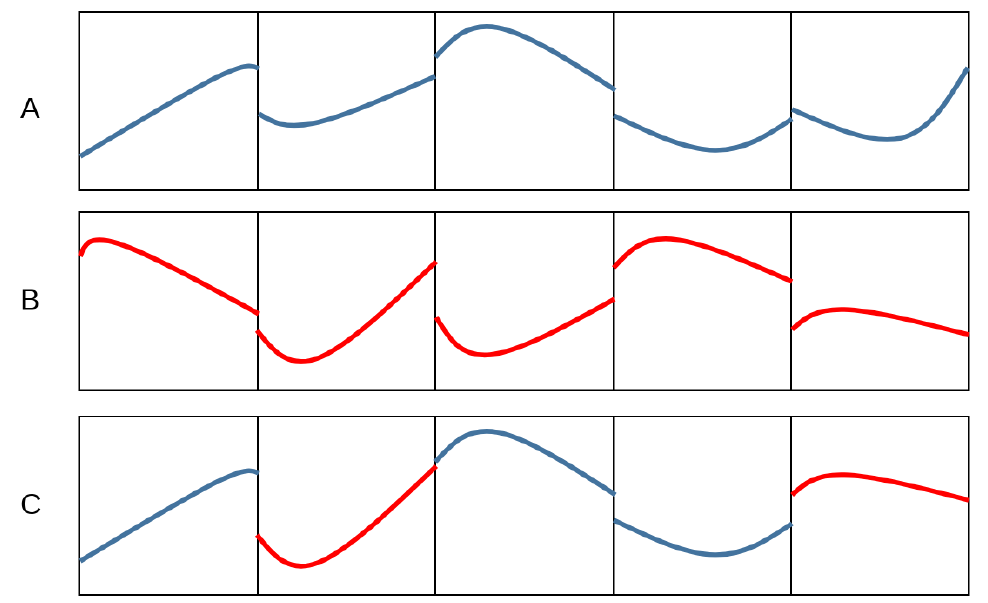
Figure 2. An illustration of the recombination methodology used, where ( A , B ) represent two candi- date solutions selected from the existing population and ( C ) presents the resulting candidate solution after the crossover between ( A ) and ( B ) is